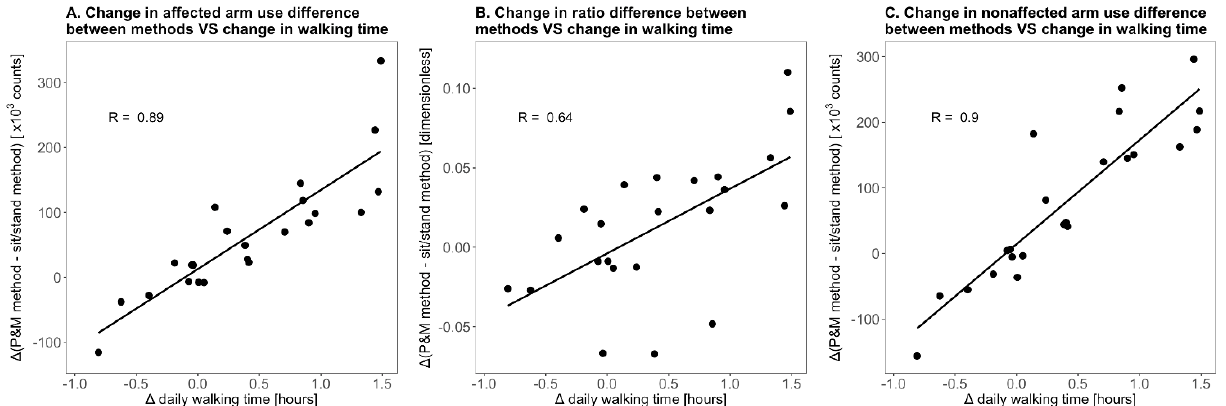
Figure 6. Scatterplots showing the change in daily walking time from week 3 to week 26 poststroke versus the change in arm use outcome difference between the P&M method and the sit/stand method from week 3 to week 26 poststroke.